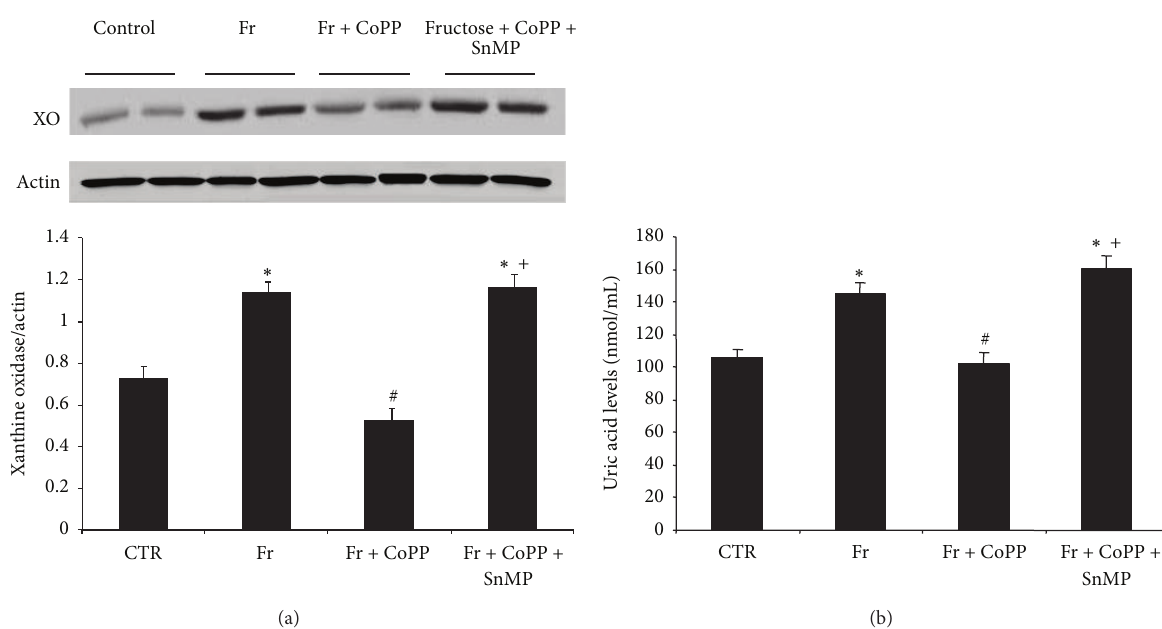
Figure 2: (a) XO expression by western blot analysis. Data are shown as mean band density normalized to 𝛽 -actin. Results are means ± SE, 𝑛 = 4 /group. ∗ 𝑝 < 0.05 versus CTR; # 𝑝 < 0.05 versus Fr; and + 𝑝 < 0.05 versus Fr + CoPP. (b) Measurement of uric acid levels in pelleted cells at day 14 of adipogenesis in human MSCs treated with 500 𝜇 M fructose with or without CoPP, in the presence or absence of SnMP. Values represent means ± SEM of five independent treatments. ∗ 𝑝 < 0.05 versus CTR; # 𝑝 < 0.05 versus Fr; and + 𝑝 < 0.05 versus Fr +